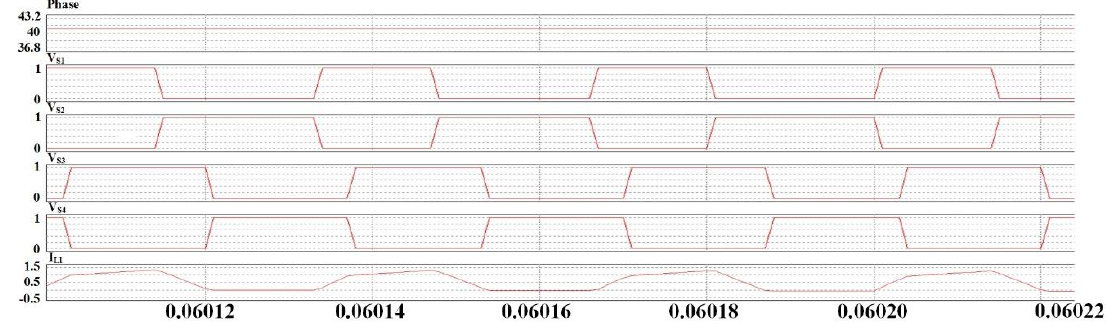
Figure 11. Simulated gating signals and inductor current under buck-charging mode (load = 50 W).